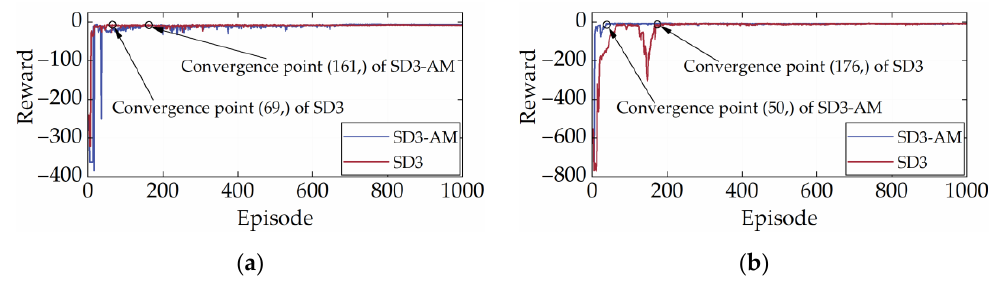
Figure 12. Reward curve under different driving cycles. ( a ) CHTC-B; ( b ) WVUCITY.